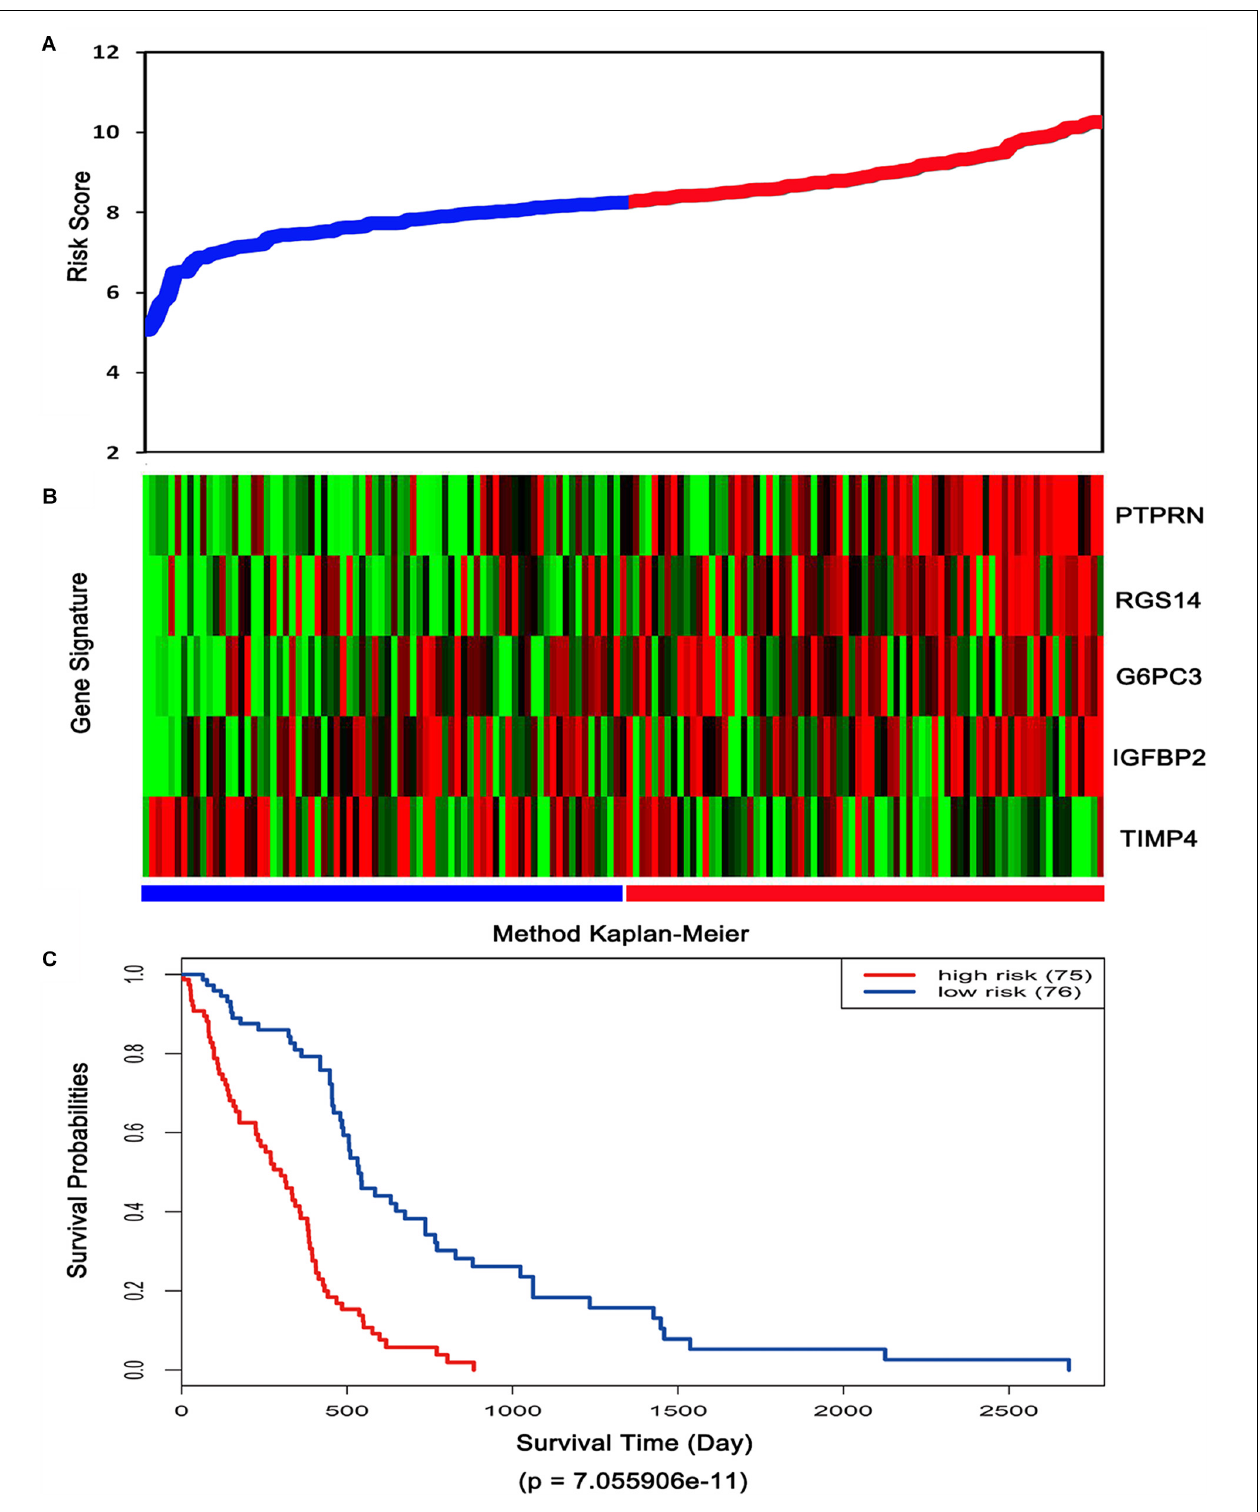
FIGURE 3 | Risk score analysis, expression distribution and survival analysis of the five-gene signature in TCGA dataset. (A) The five-gene signature risk score distribution. (B) The heat-map of the five-gene expression profiles. Red indicates a higher expression and green indicates a lower expression. Blue bar: low-risk group. Red bar: high-risk group. (C) Kaplan–Meier analysis using the median risk score cut-off which divided patients into low-risk and high-risk groups.